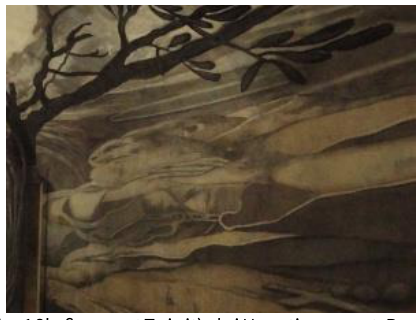
Fig. 18b fresco at Trinità dei Monti convent, Rome Thanks to the rhythmic succession of concave and convex wavy parts and to the adoption of innovative and unusual designs, the Baroque buildings give the illusion that a fantasy world is opening up before the onlooker. (Figures19 and 20 ). Fig. 16 The Chapel of the Holy Shroud, Turin (Guarini, 1668)